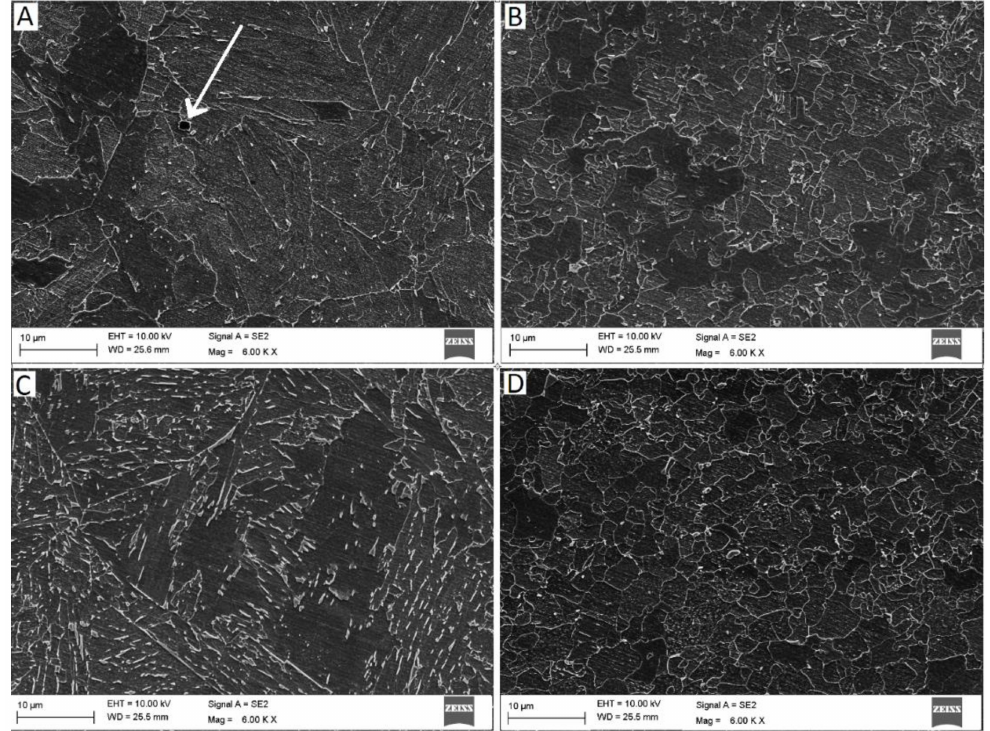
Figure 14. SEM images from low heat input (t 8/5 = 5 s) weld HAZ for steel S700MC-1. ( A – D ) are locations established in Figure